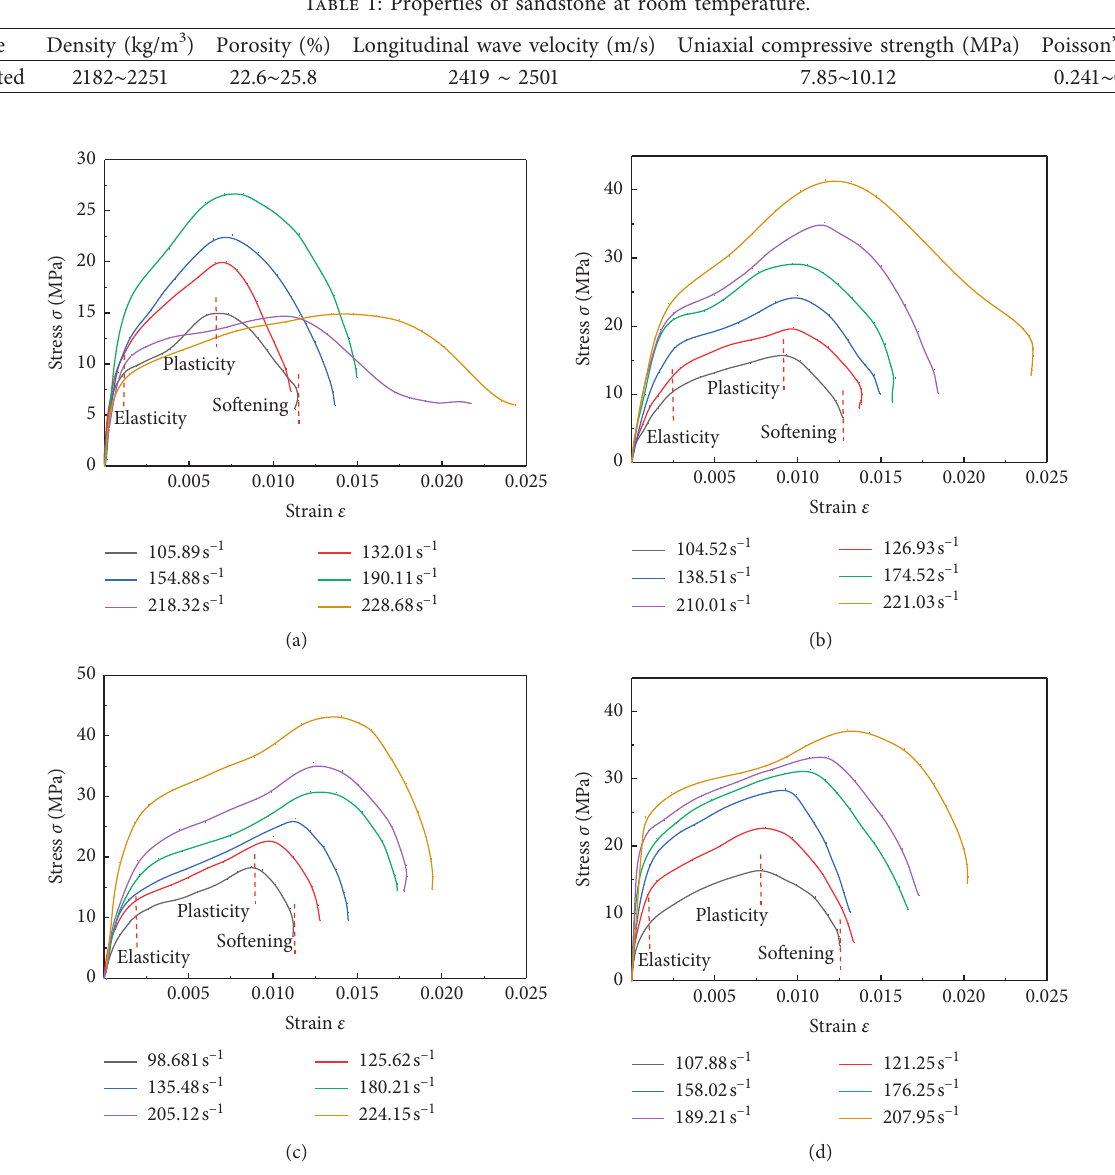
Figure 3: Stress-strain curves of sandstone at different temperatures: (a) T � 20 ° C; (b) T �− 10 ° C; (c) T �− 20 ° C; (d) T � − 30 °